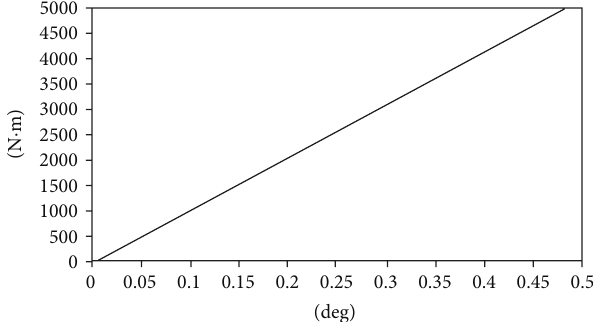
Figure 7: Rotational stiffness curve (around 𝑦 or 𝑧 direction).